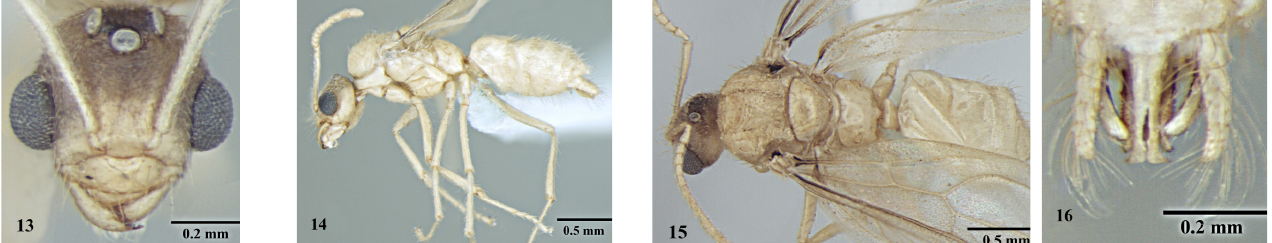
Fig. 13-16. Pseudolasius diversus sp. n ., male 13) head, full face view; 14) body, lateral view; 15) body, dorsal view; 16) genetalia, dorsal view.